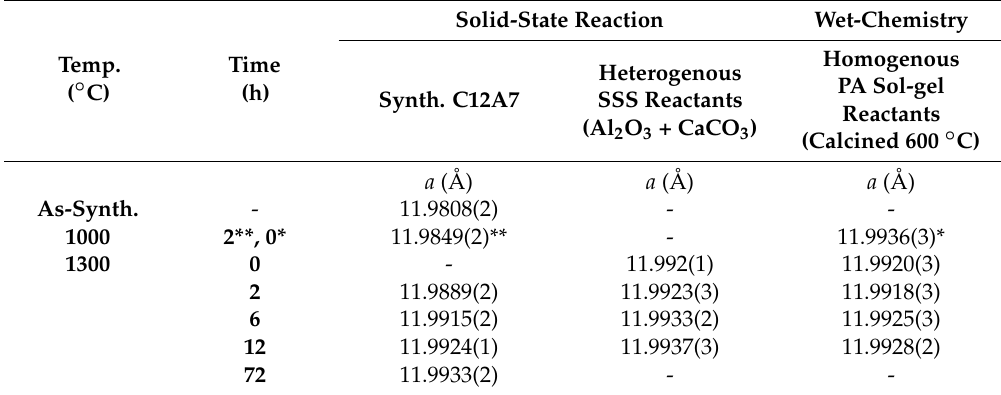
Table 1. Comparison of C12A7 lattice parameter after undergoing processing with a carbonaceous die in a vacuum furnace from a variety of starting points; previously synthesized oxy-C12A7, heterogenous solid-state reactant mixture, and atomic homogenous calcined polymer assisted sol-gel reactant mixture are the various starting points. Errors are represented as 3 σ